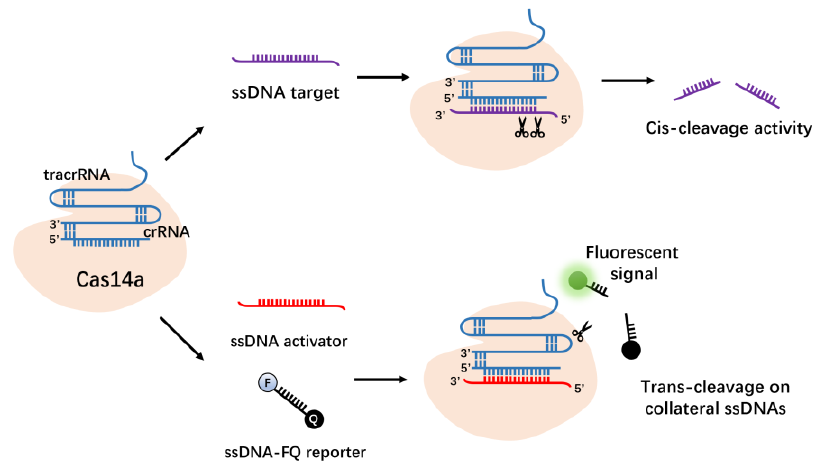
Figure 7. CRISPR–Cas14a has cis- and trans-cleavage activity on single-stranded DNA. Figure 7. CRISPR – Cas14a has cis- and trans-cleavage activity on single-stranded DNA.